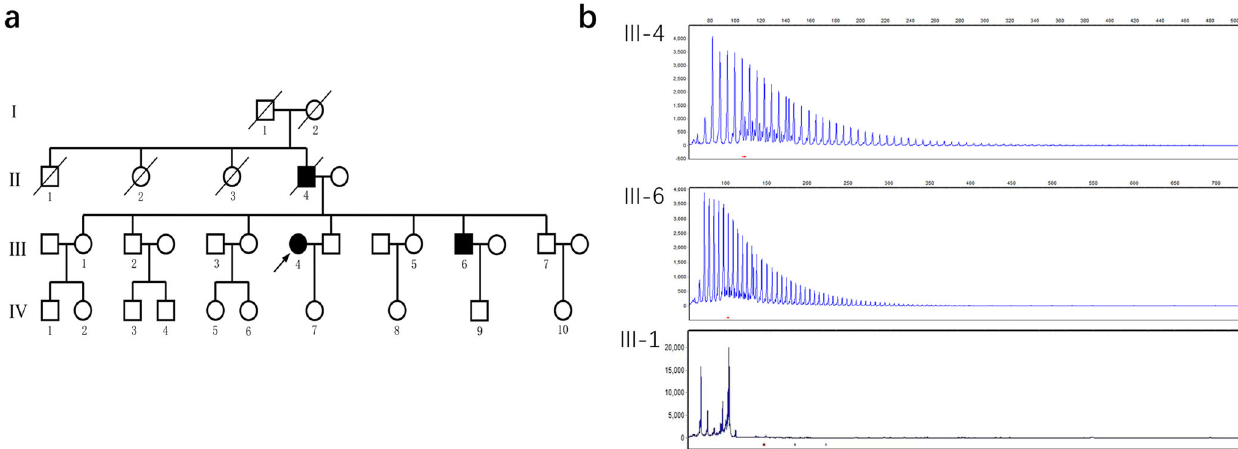
Fig. 1 FTDP pedigree with C9ORF72 repeat expansions. a Pedigree tree of the family with the repeat expansion mutation in C9orf72. There were three symptomatic patients in four generations of this pedigree. b Results of repeat primed PCR for C9orf72 expansion demonstrating the saw-tooth pattern, typical of the pathological expansion. Repeats are measurable up to 52 hexanucleotide repeats. Both the proband (III-4) and her brother (III-6) carry the C9orf72 repeat expansion. The proband ’ s sister (III-1) has a normal C9orf72 genotype (2/8) and is alive and healthy at the age of 80